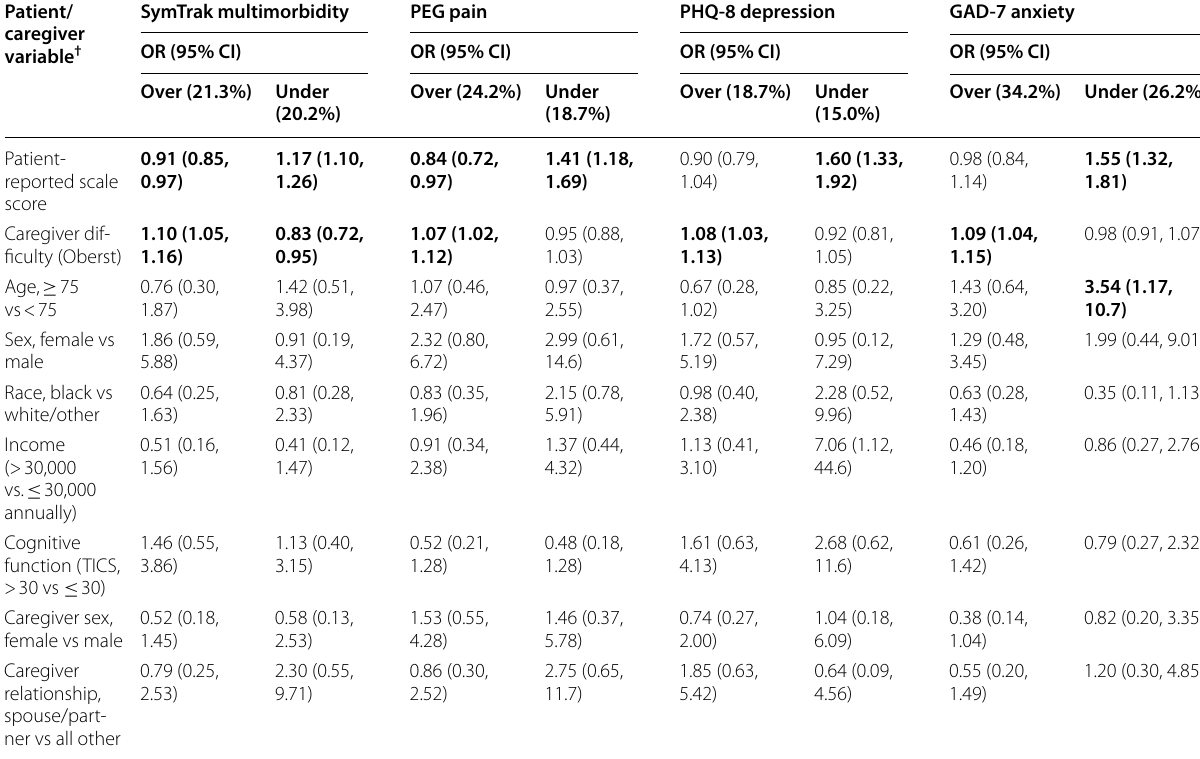
Table 6 Multinomial Logistic Regression Models: Correlates of Caregiver Overreporting and Underreporting of Patient-Reported Scale Scores (Four models were run–one for each scale score. Each model has a 3-level dependent variable, with concordance being the reference group; the odds ratios (ORs) for over- and under-reporting are relative to the reference group Differences are calculated as (Caregiver-estimated score) ‒ (Patient-reported score). Concordance was defined as a difference within 2 standard errors of ± measurement (SEM). Overreporting Difference > 2 SEM higher. Underreporting Difference > 2 SEM lower. Percentages in column = = headings are the proportion of caregivers that over- and underreported for each